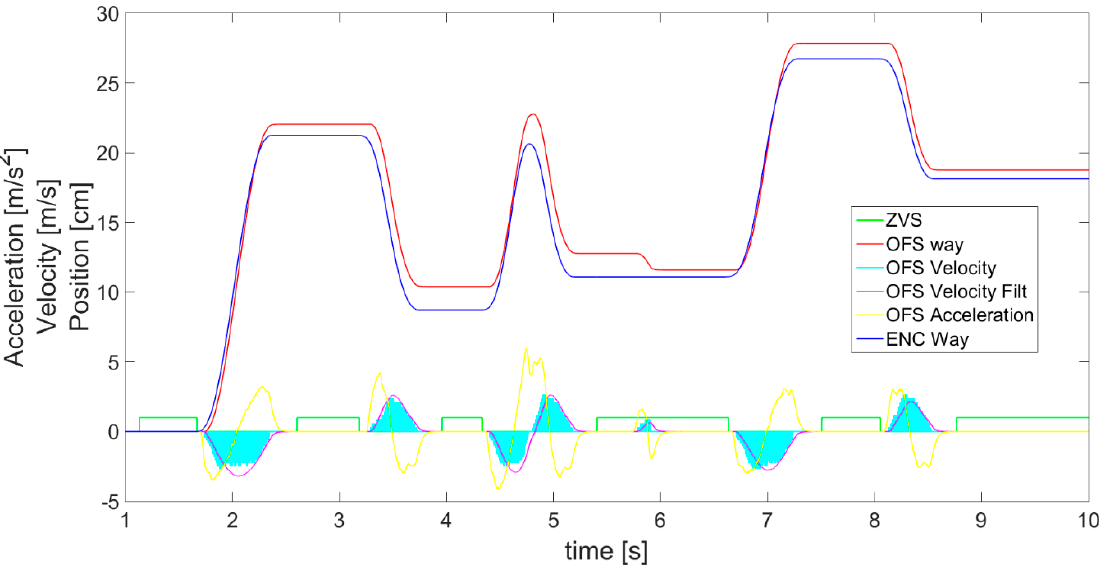
Figure 15. OFS filtered and scaled readings together with those calculated on the basis of the values of acceleration (yellow) and displacement (red).